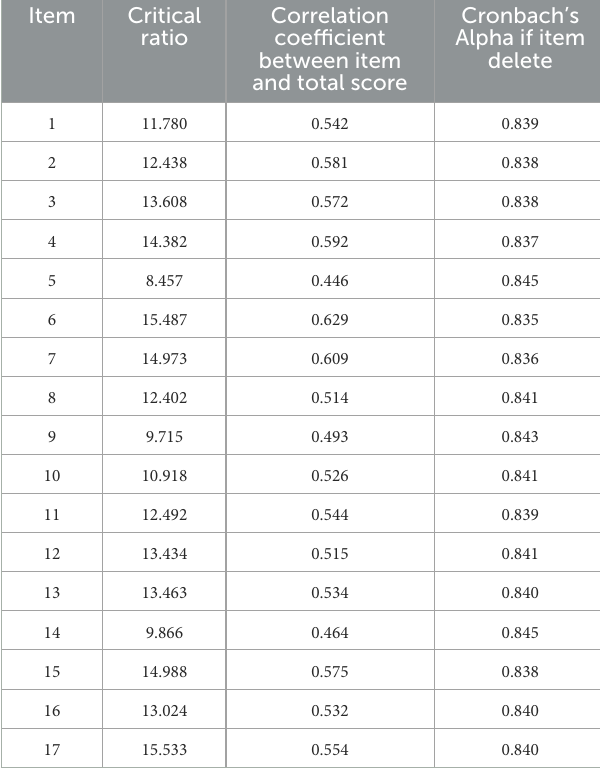
adults undergoing hip fracture surgery. Item Critical Correlation ratio